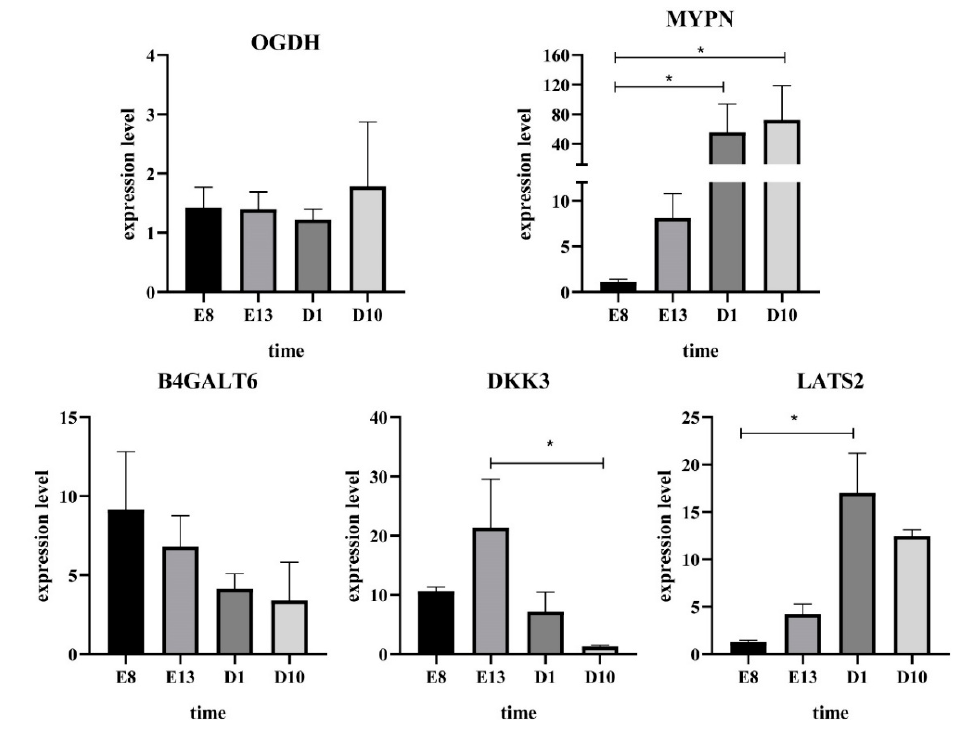
Figure 6. Validation of hub genes using RT − qPCR. “*” was considere dsignificant difference ( p < 0.05)